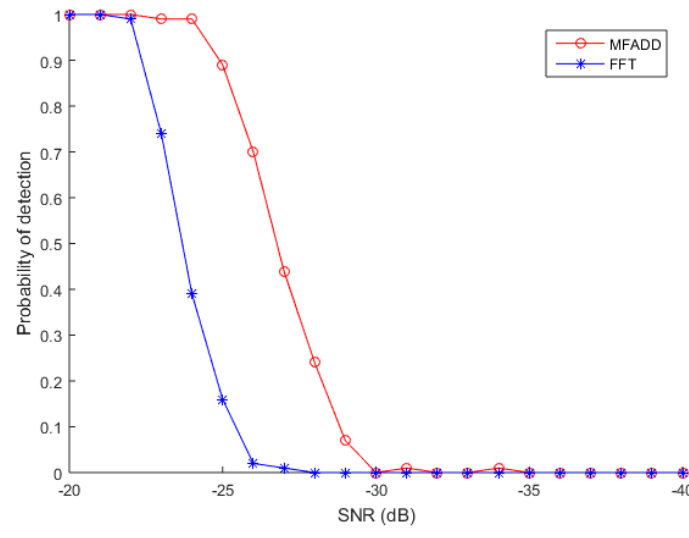
Figure 13. Comparison of detection probability.